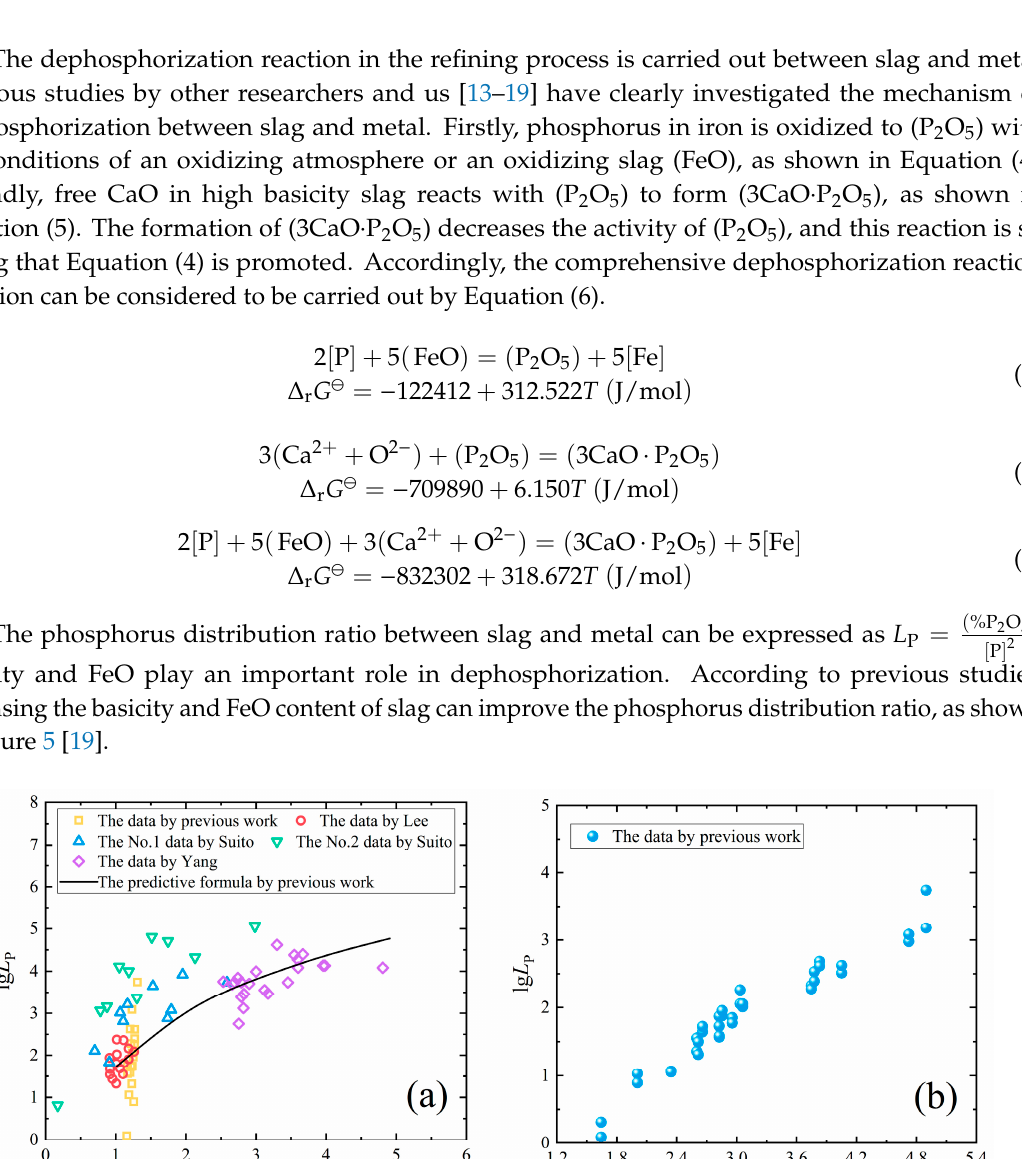
Table 3. The composition of slag used for dephosphorization.